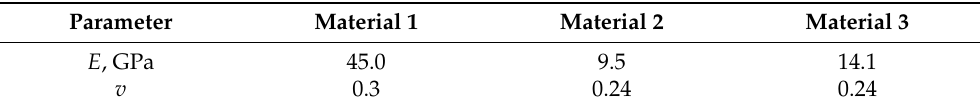
Table 2. Physical-mechanical properties of the prosthetic inlay materials. Parameter Material 1 Material